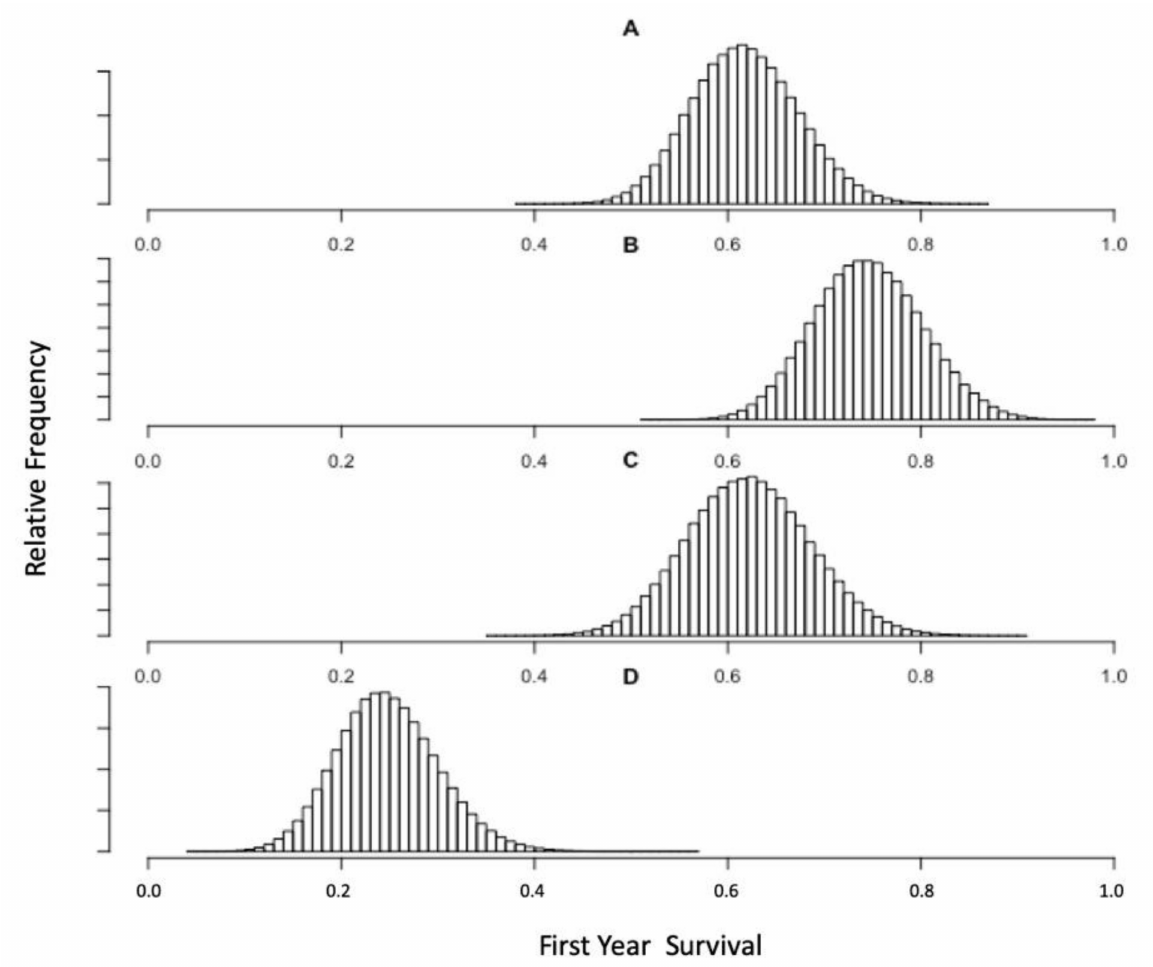
Figure 7. Posterior distributions for the probability of first-year survival for St. Paul fur seal pups following four categories of eastern Bering Sea pollock catch in the same year. ( A ) Distribution for the years 1955 to 1963, prior to the rapid increase in pollock catches. ( B ) Distribution for years classified as periods of low catch (<750,000 t). ( C ) Distribution for years of moderate catch (750,000 t < catch < 1,050,000 t). ( D ) Distribution for years classified as periods of high catch (>1,050,000